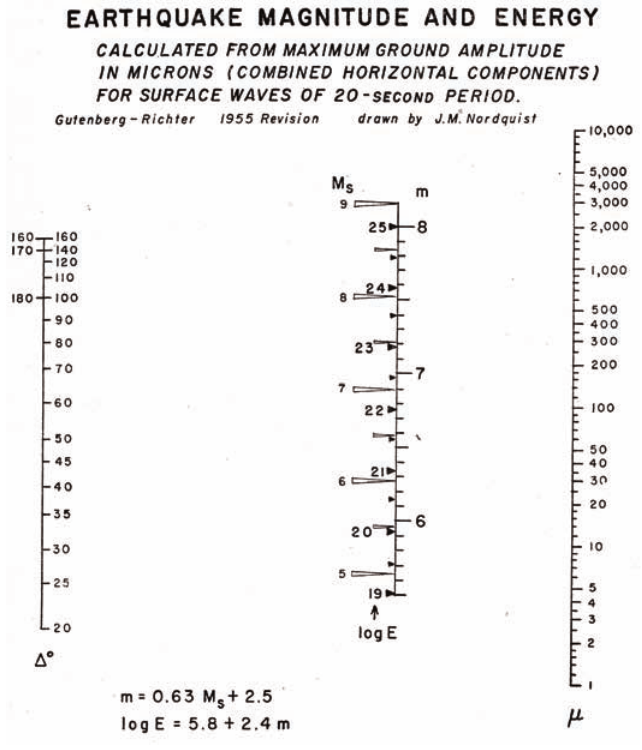
from surface S and of log E from equa- S